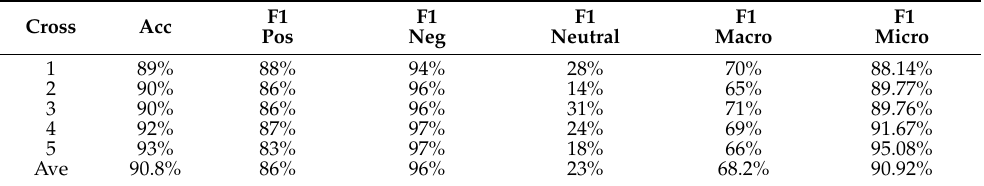
Table 5. Five cross-validation performances of RoBERTa on the LFSC-A dataset.